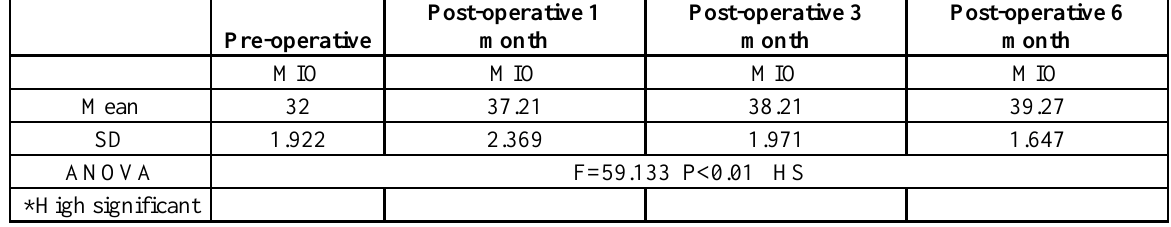
Table 2: MAXIMUM MOUTH OPENING Results